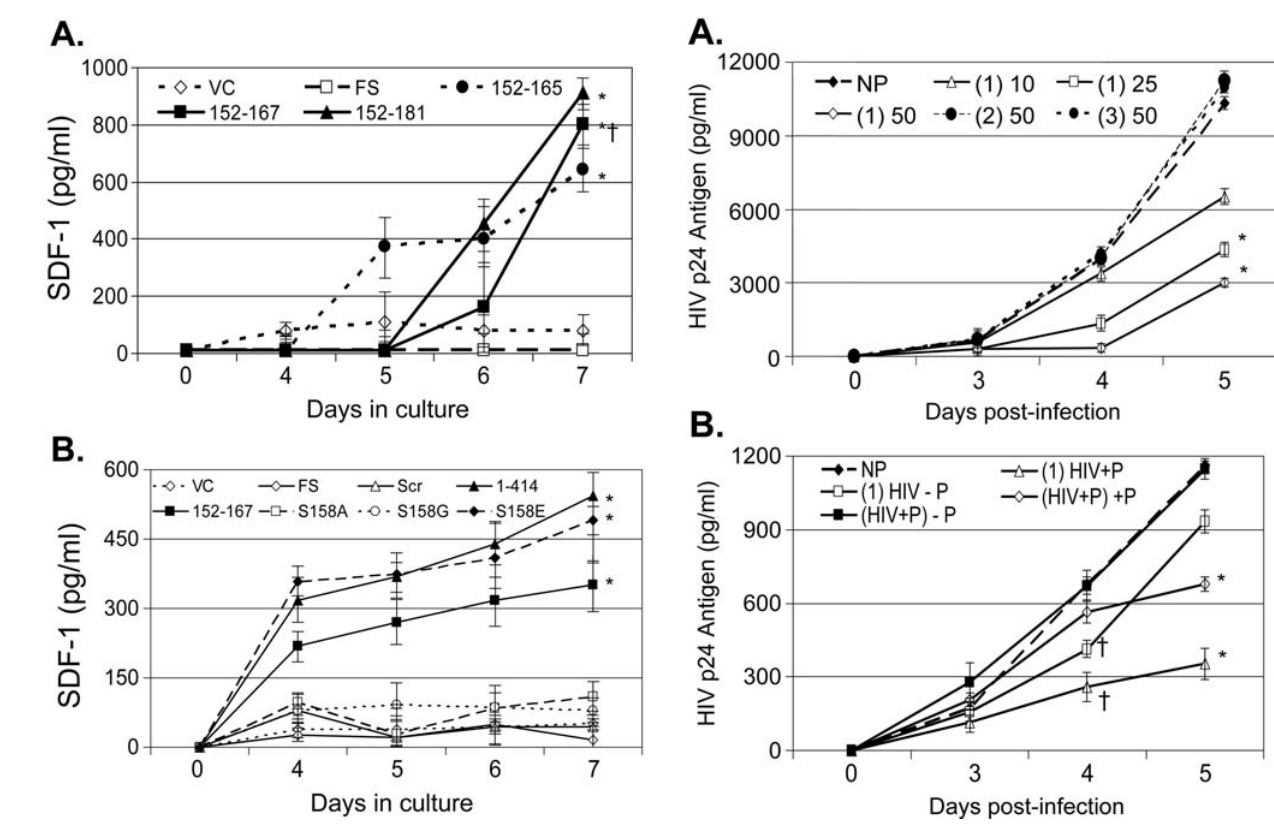
Figure 7. GBV-C NS5A peptides increase the release of stromal cell-derived factor 1 (SDF-1). SDF-1 release into culture superna- tants was significantly greater in cell lines expressing GBV-C NS5A peptides 152–165, 152–167 and 152–181 compared to the vector control (VC) or frame shift (FS) cell lines after 7 days in culture (* p , 0.01 for all; panel A). Jurkat cells expressing full-length NS5A (1–414), the 152–167 peptide and the S158E mutant peptide also induced significantly more SDF-1 than did cells expressing VC, FS or the S158A and S158G peptides (B; * p , 0.02 for all on day 7).